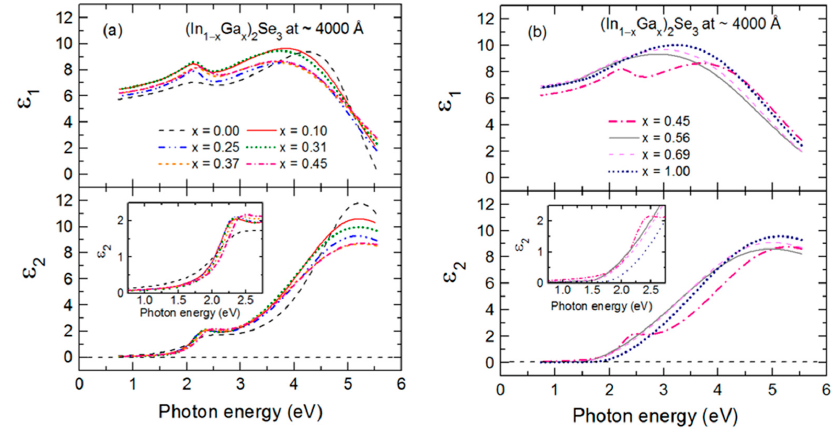
Figure 5. Parametric forms of the complex dielectric function spectra ( ε 1 , ε 2 ) for IGS films at bulk layer thicknesses within the range of 3500–4100 Å measured at 400 °C for ( a ) x ≤ 0.45 and ( b ) x ≥ 0.45. These ( ε 1 , ε 2 ) spectra generate the best fits to the results obtained by inversion at the center of the time range used for multi-time analysis. A high energy Tauc-Lorentz oscillator is used over the full range of x , whereas a bandgap CP oscillator is clearly observable in the ( ε 1 , ε 2 ) spectra only for the IGS depositions with x ≤ 0.45.